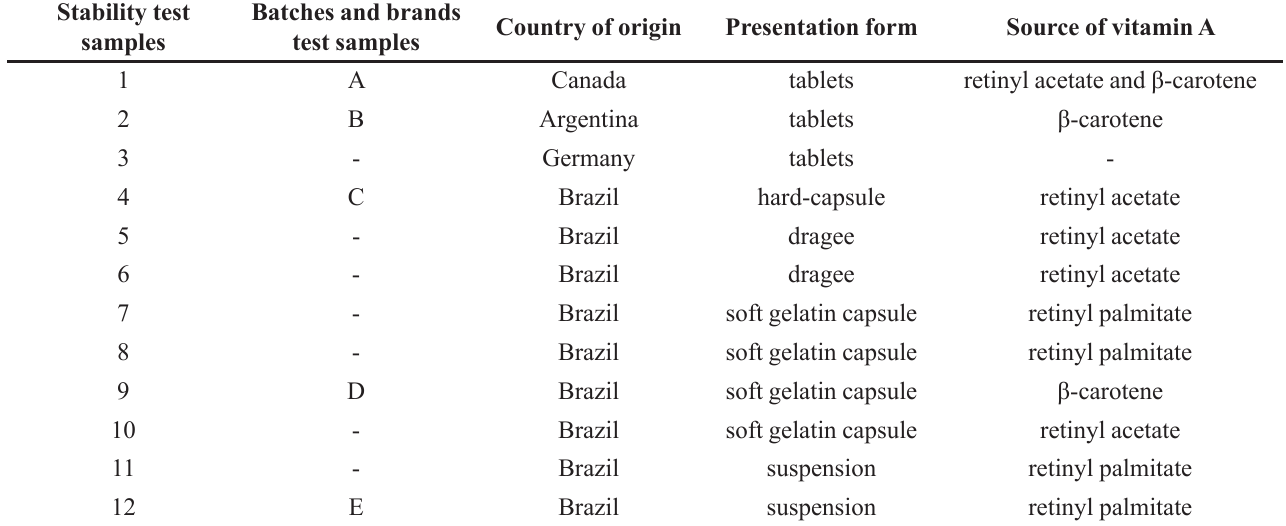
TABLE I - Characteristics of the vitamin supplements evaluated in the stability testing and the examination of batches and brands